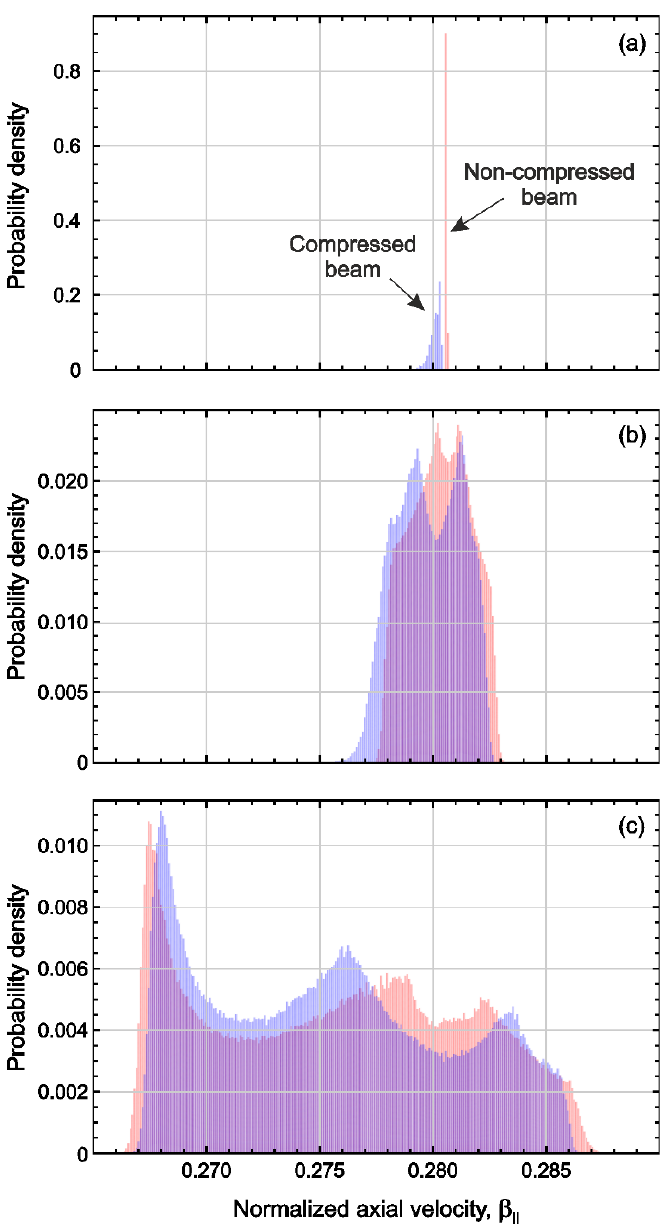
Figure 11. Velocity distributions for the compressed (blue) and non-compressed (red) beam at the ( a ) input and output of the SWS in ( b ) small-signal and ( c ) large-signal mode.